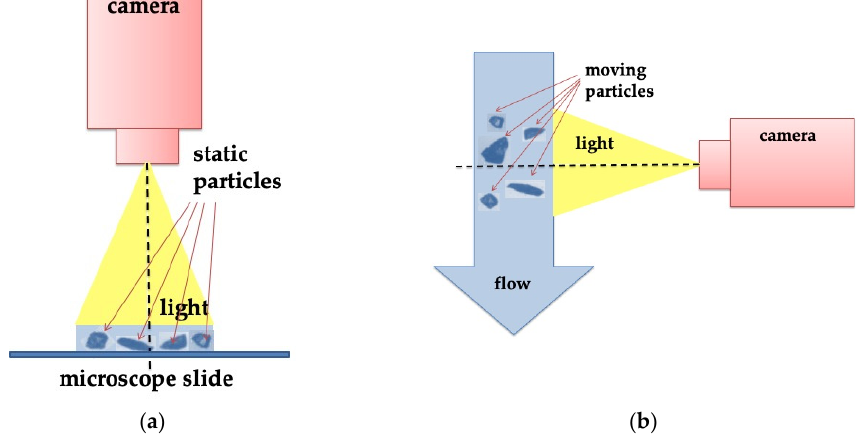
Figure 17. Schematic illustrations of two different image analyses: ( a ) SIA; ( b )